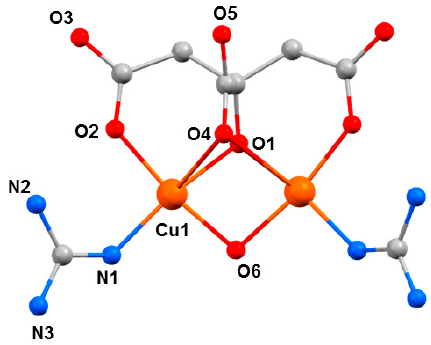
Figure 9. The molecular structure of the anion in 7 . Colour code: Cu = orange, O = red, N = blue, C = grey. H atoms and the counter cation are omitted for clarity.